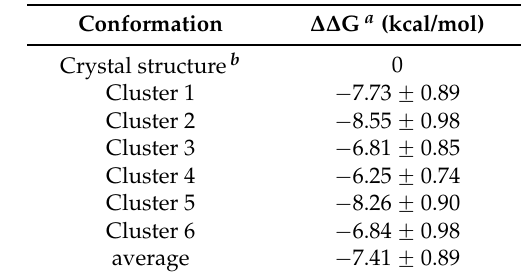
Table 1. Relative free energy of interdomain interactions in WT